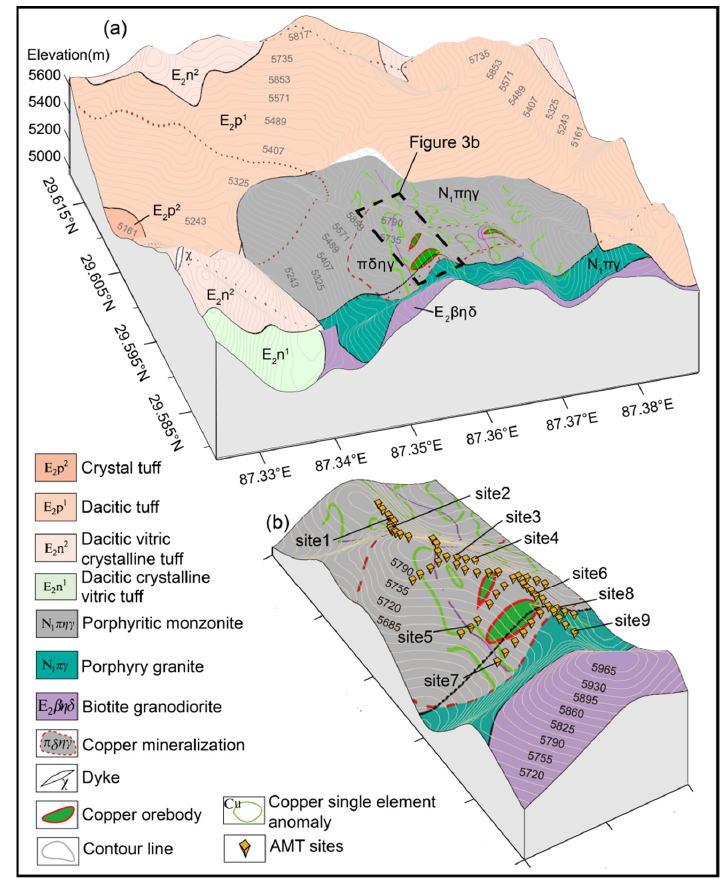
Figure 3. ( a ) The superposition of geological map and topographic map of the Cimabanshuo deposit with the highest elevation being higher than 5900 m, the lowest elevation reaching nearly 5100 m and an average value of ~5500 m. ( b ) Locations of AMT sites of this research. The geological map in Figure 3a is same as Figure 2b and modified from